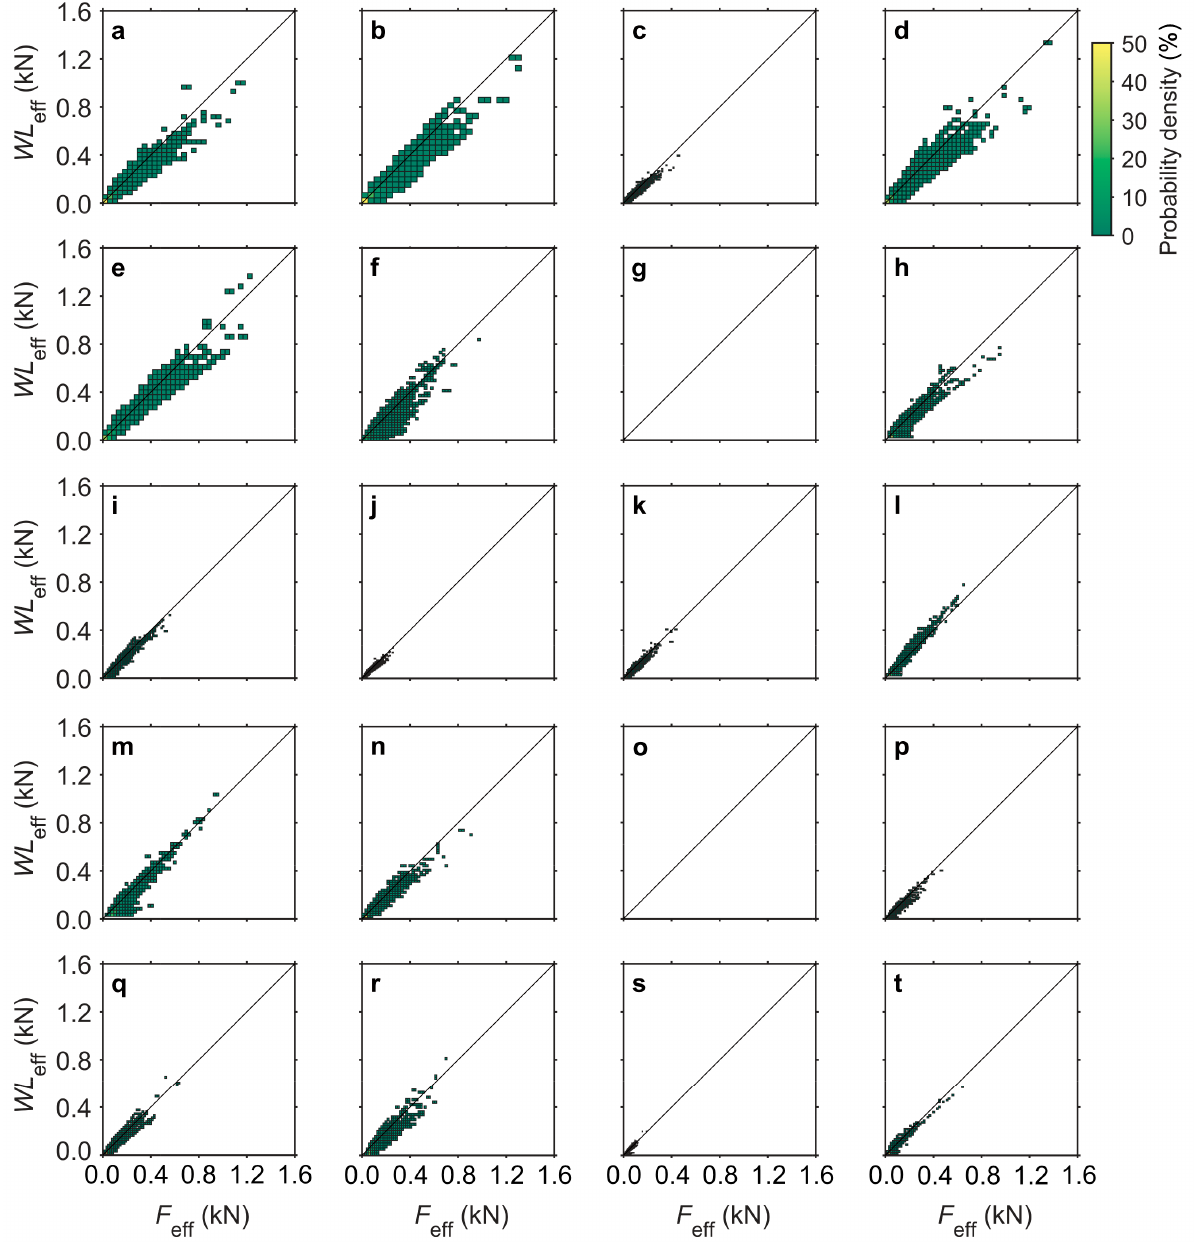
Figure 9. ( a–t ) Bivariate histograms of instantaneous WL eff and F eff of B1 to B20 in the study period. Due to measurement device failure there is no data for B7 and B15.